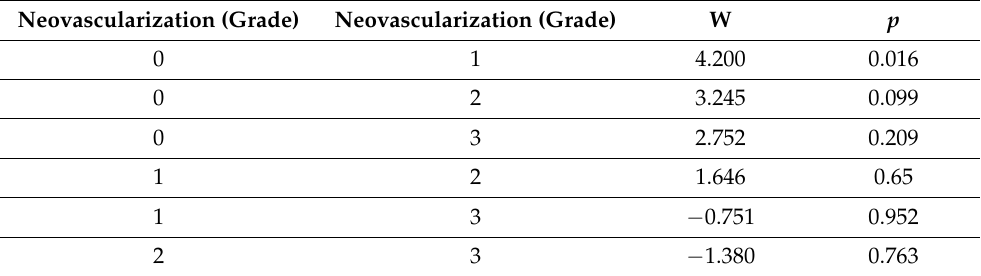
Table 12. Dwass–Steel–Critchlow–Fligner pairwise comparisons (intensity ratio) for the variable “neovascularization” after the Table 1, and Column 2 represent the paired neovascularization grades in